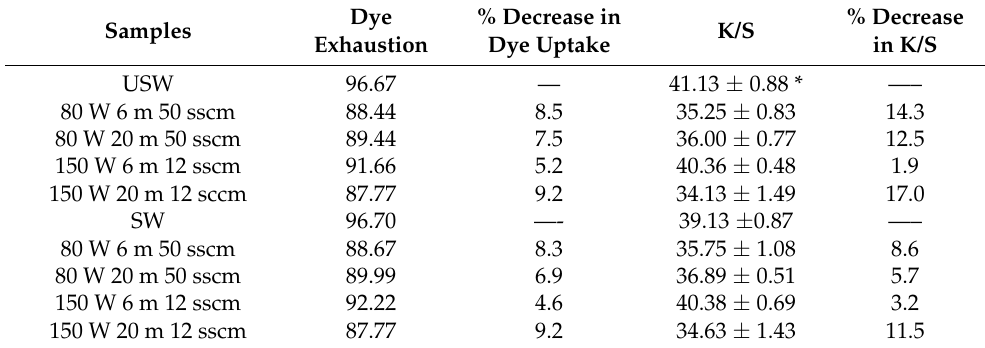
Table 3. Dye uptake and K/S values of untreated and plasma-treated wool fabrics. Dye % Decrease in Samples Exhaustion Dye